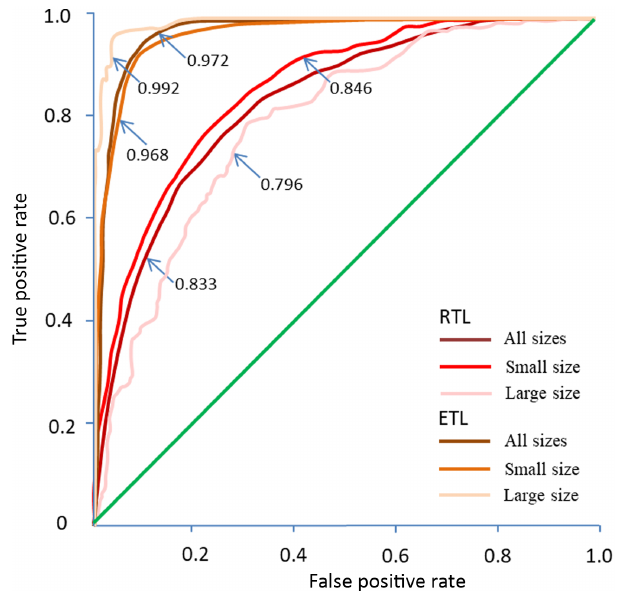
Figure 8. ROC curves for the susceptibility assessment models for different sizes of RTLs and